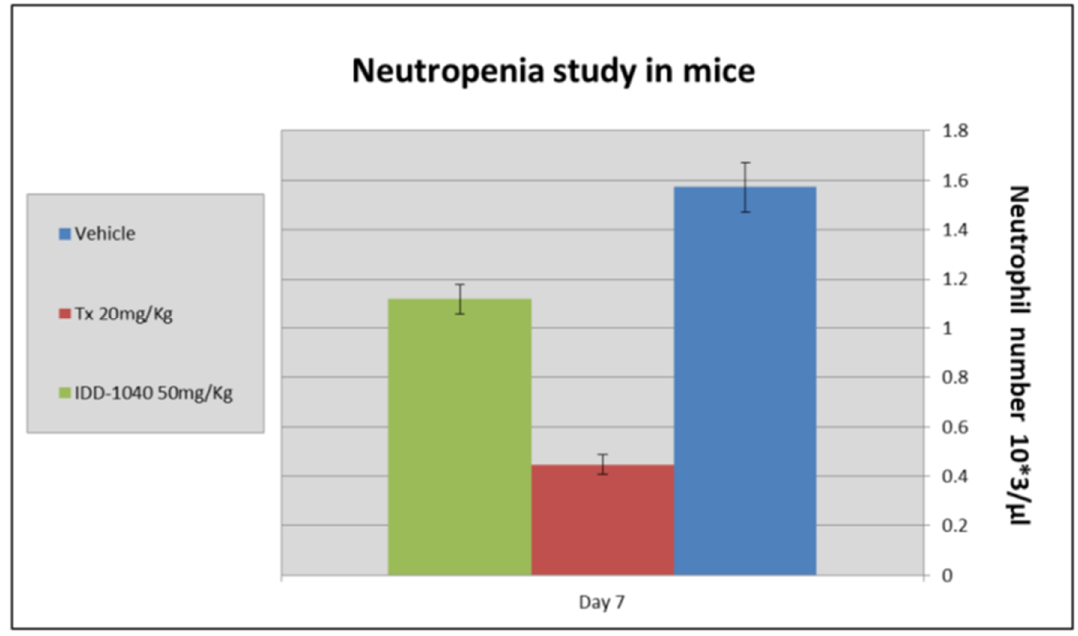
Figure 8. Assessment of neutropenia in mice treated with vehicle control (blue) and IDD-1040 (green) versus PTX (red).